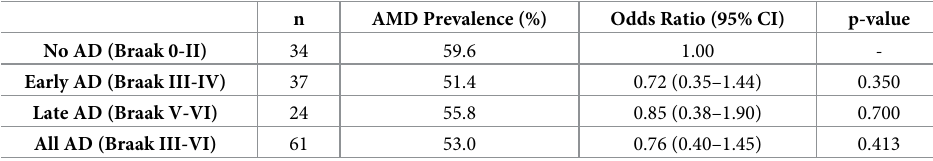
Table 3. Association between AD stages and